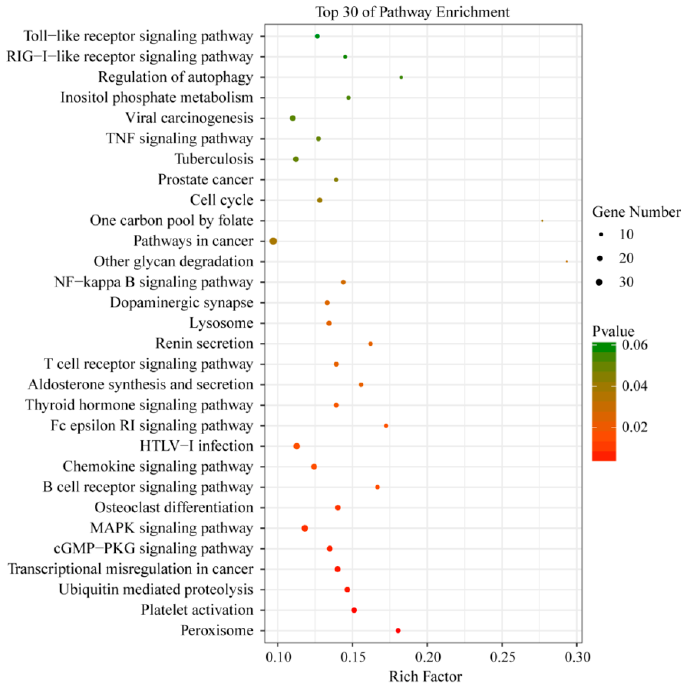
Figure 7. KEGG pathways of the differentially expressed genes. Rich factor is the ratio of the number of genes located in the KEGG pathway to the total number of genes in the KEGG pathway. The top 30 KEGG pathways are listed according to a p -value < 0.05.